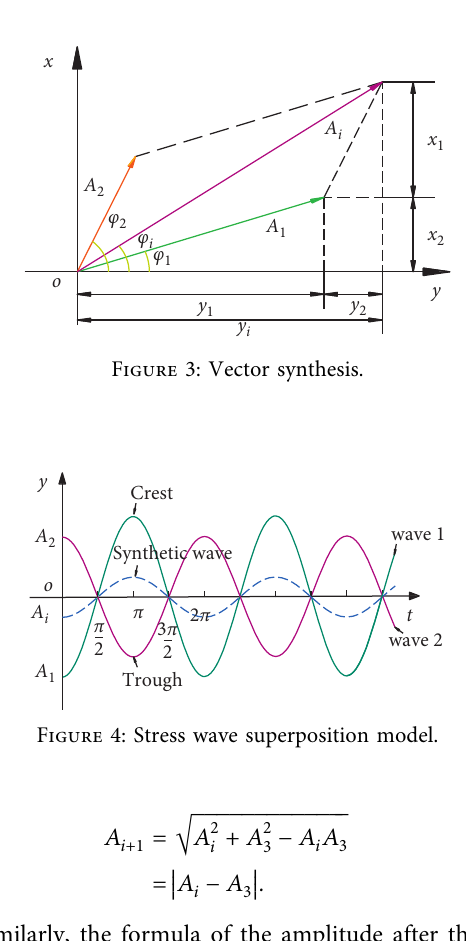
Figure 2: Phase superposition model of blasting stress wave.